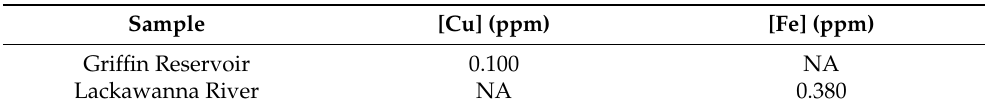
Table 2. Calculated concentrations in Griffin Reservoir, Keyser Creek, and Lackawanna River samples. “NA” implies that the metal was not tested for that specific sample